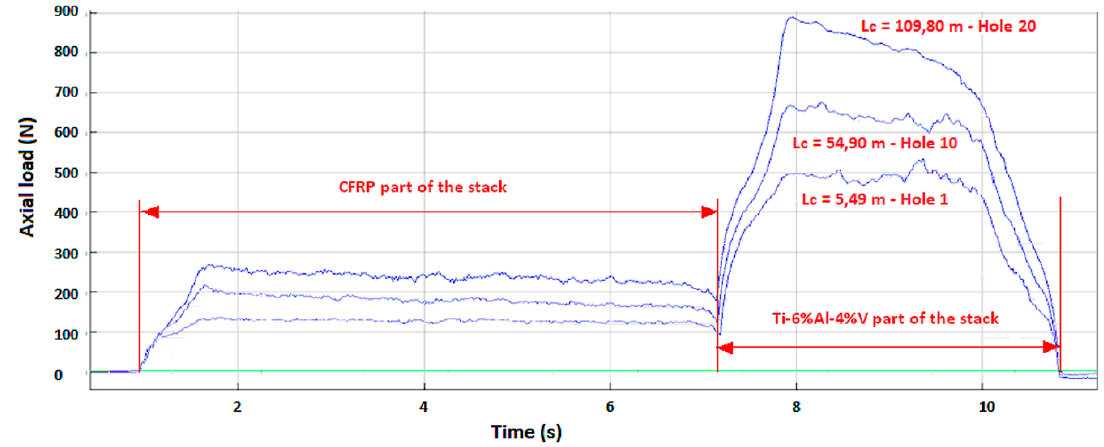
Figure 8. Thrust force versus time in CFRP/Ti-6%Al-4%V stacks.